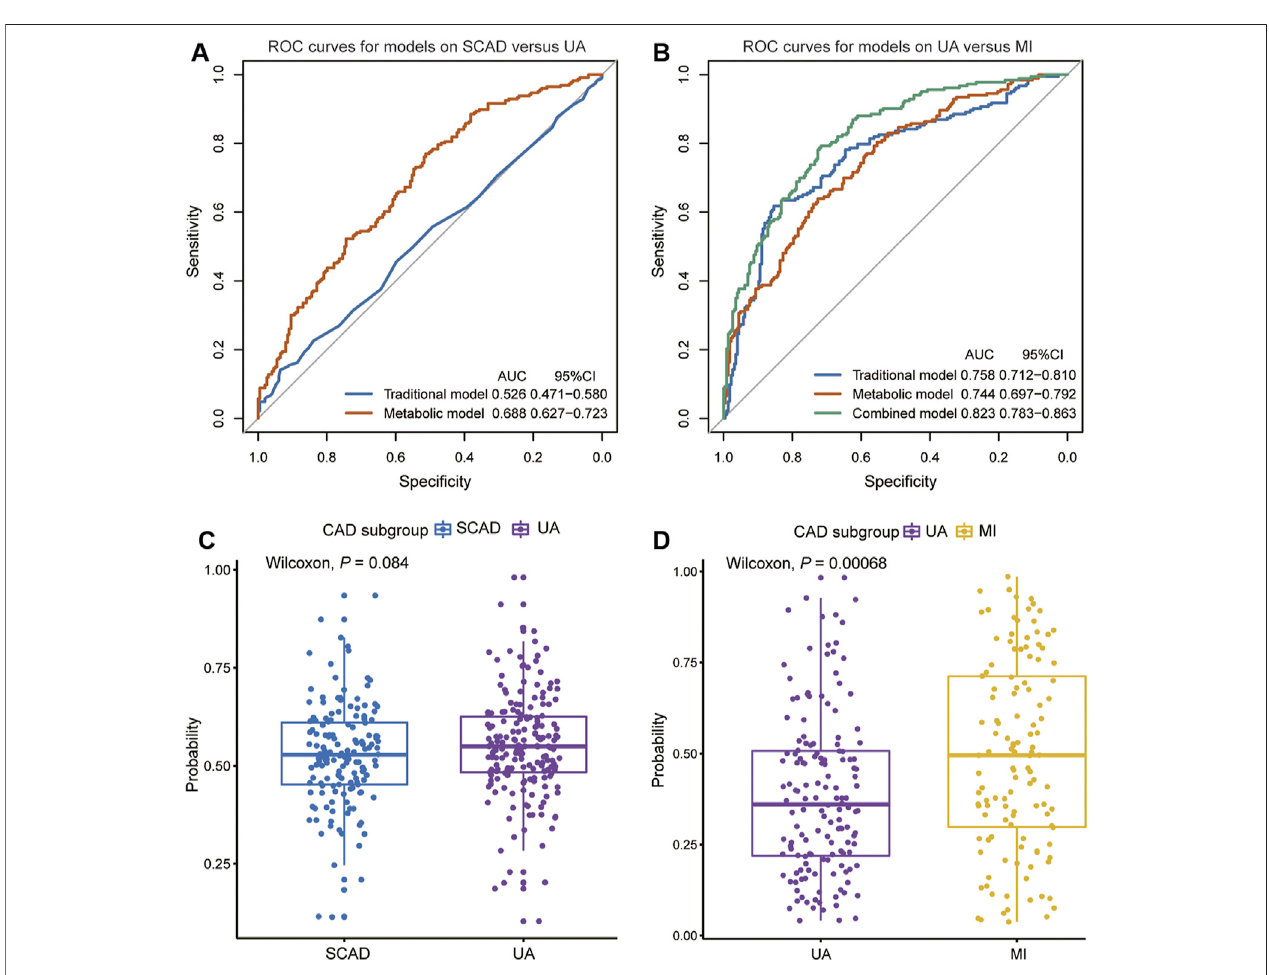
FIGURE 4 | Diagnostic performances in discovery cohort are shown via ROC curves between (A) SCAD vs. UA (B) UA vs. MI. The combined diagnosis score in validation cohort were compared between (C) SCAD and UA patients (D) UA and MI patients. AUC, area under curve; CI, con fi dence interval; ROC, receiver operating characteristic; other abbreviations as in Figure 1 .